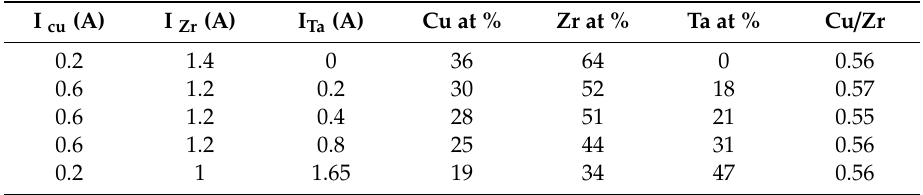
Table 1. Discharge current and corresponding elemental